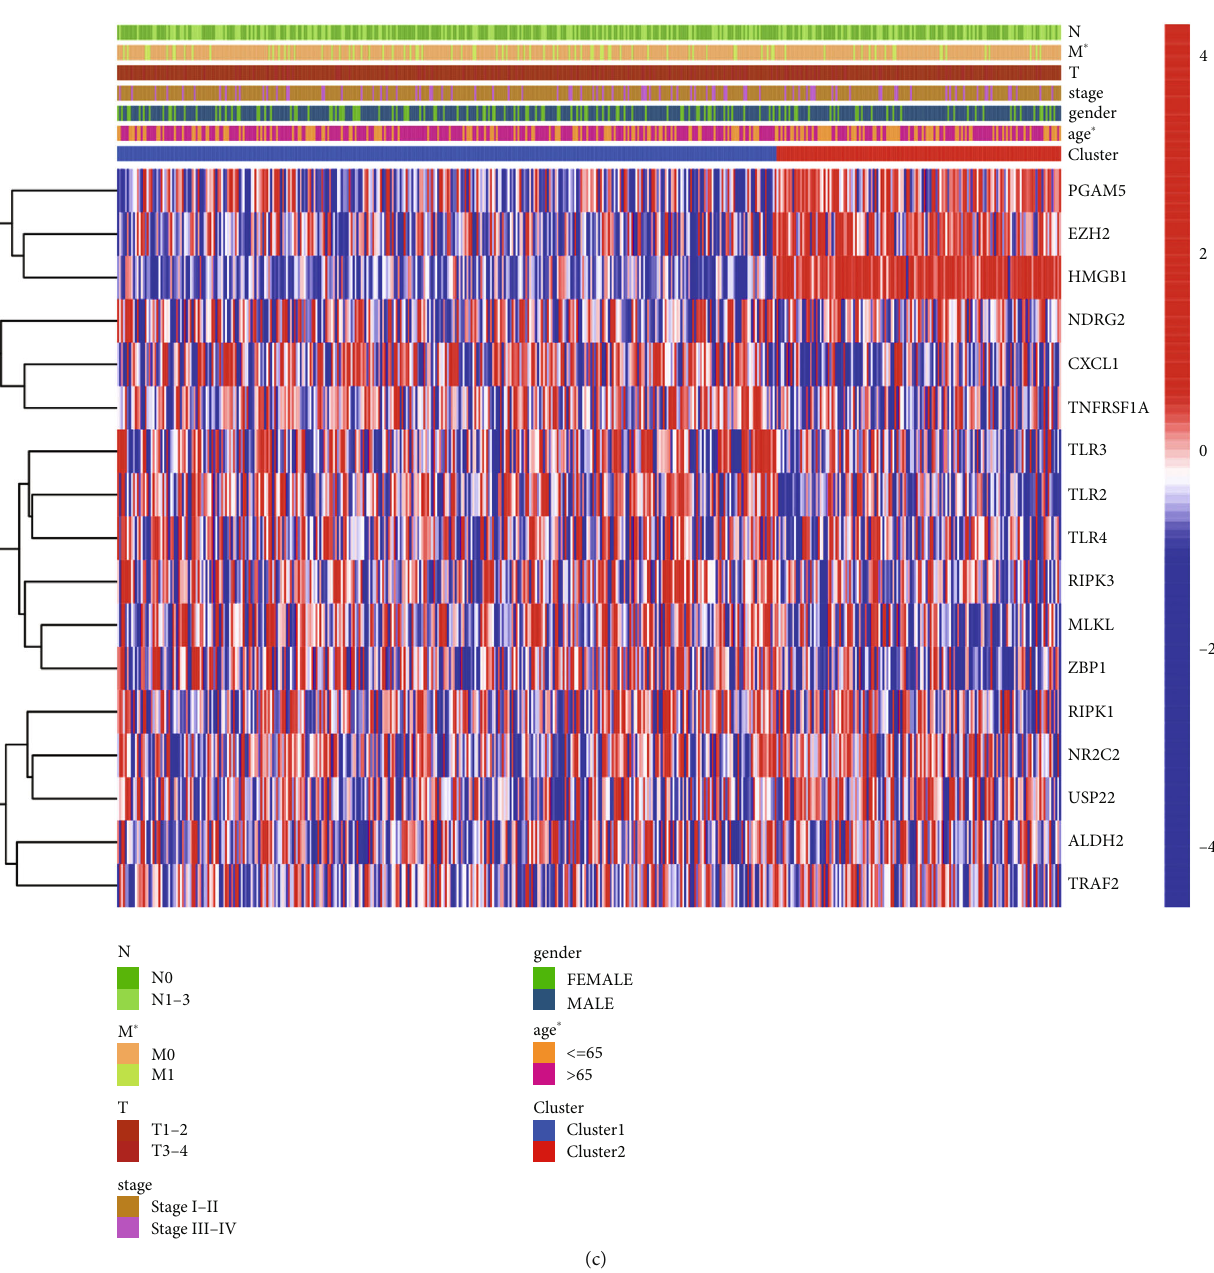
Figure 2: Consensus clustering identi fi ed two clusters of LUAD. (a) Consensus clustering matrix about two clusters of LUAD. (b) Overall survival curve in two clusters of LUAD. (c) Heatmap revealed the di ff erence in clinicopathologic features between the two clusters. * P < 0 : 05